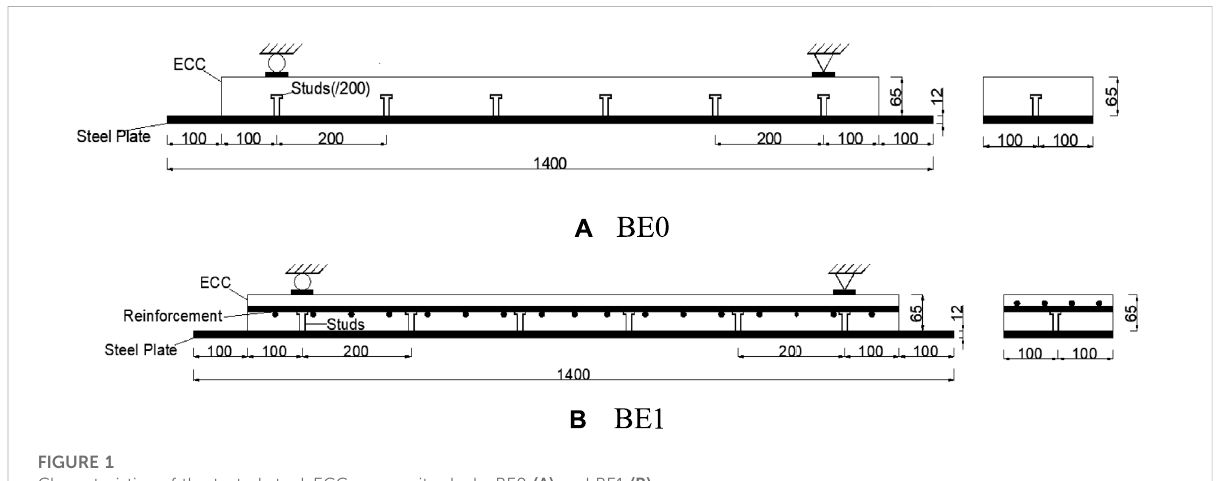
FIGURE 1 Characteristics of the tested steel-ECC composite decks BE0 (A) and BE1 (B)